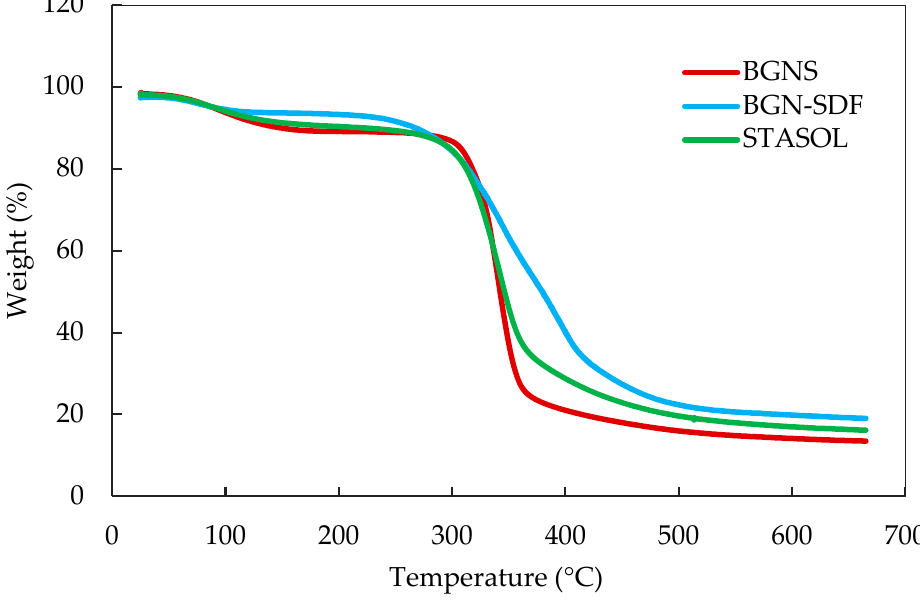
Figure 8. Thermal properties of BGNS, BGN-SDF and STASOL using TGA. BGNS = Bambara groundnut starch; BGN-SDF = Bambara groundnut soluble dietary fibre; STASOL = Bambara groundnut starch-fibre nanocomposite; TGA = thermogravimetric analysis.